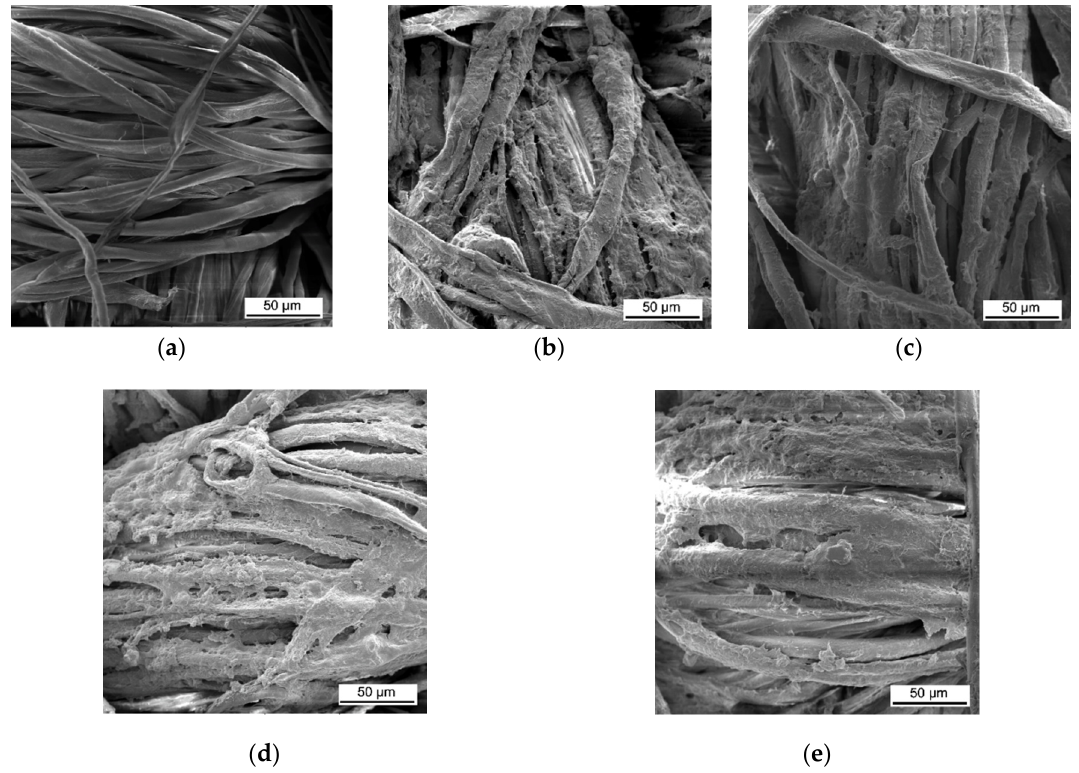
Figure 5. SEM images of ( a ) untreated cotton and ( b ) cotton treated with 8, ( c ) 10, ( d ) 12, and ( e ) 15 Figure 5. SEMimagesof( a )untreatedcottonand( b )cottontreatedwith8,( c )10,( d )12,and( e )15bilayers(BL) bilayers (BL) chitosan (CH)-urea/phytic acid (PA). chitosan (CH)-urea / phytic acid